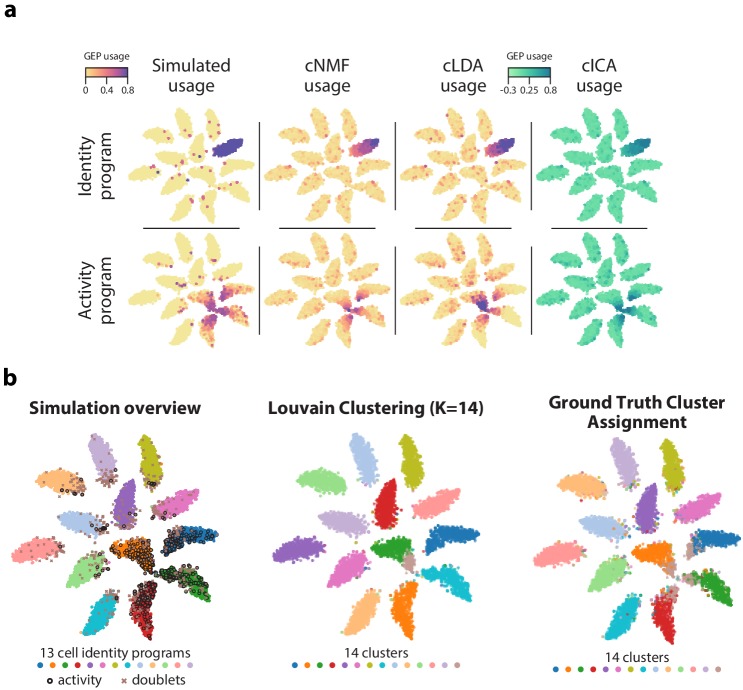
GEP usage inference.(a) Comparison of GEP usage inference by cNMF, cLDA, and cICA for an example identity GEP (top row) and the activity GEP (bottom row). Each cell is represented as a point and its usage is represented by the marker color. (b) Comparison of the results of ground truth cluster assignment and Louvain clustering represented on a t-SNE plot. (Left) Reproduction of Figure 1b which shows cells colored based on their true identity program, doublets marked with an X, and cells that express the activity program with a black border. (Middle) Cells are colored based on Louvain clustering. (Right) Cells with activity GEP usage of greater than 40% are assigned to an activity cluster, and all other cells were assigned to their identity cluster. This shows how an optimal hard clustering might behave in the context of mixed membership.